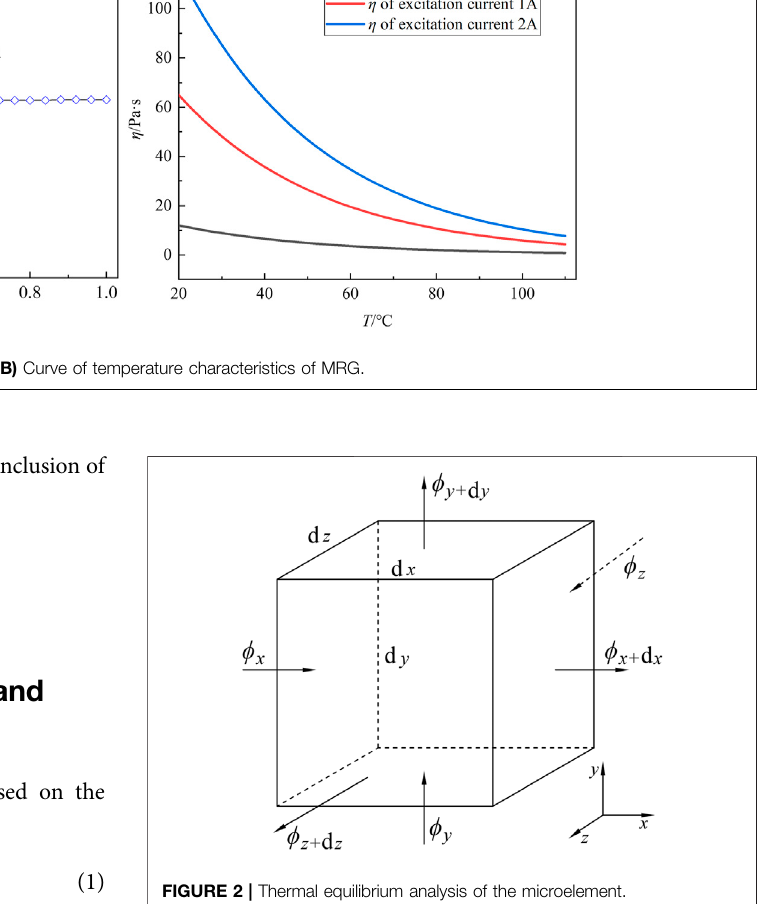
FIGURE 2 | Thermal equilibrium analysis of the